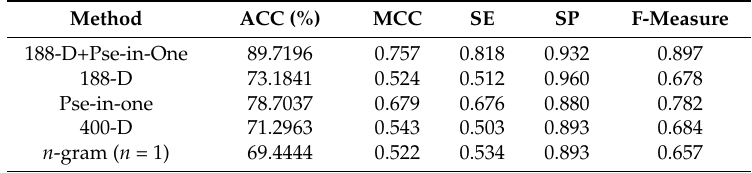
Table 2. The result of using different feature representation methods on external validation.